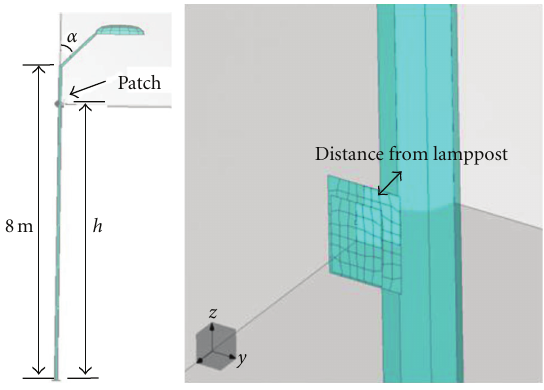
Figure 21: ISMPG distribution for antenna-shelter (standard sector).